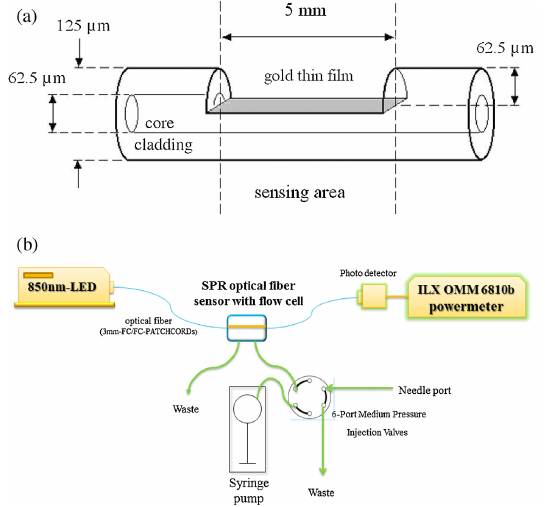
Figure 25. ( a ) Schematic diagram of the SPR optical fiber sensor featuring a side-polished structure. ( b ) The sensing system comprises an 850-nm LED light source, a side-polished SPR fiber in the flow cell, a six-port medium-pressure injection valve bulkhead, a syringe pump, a photo detector, and an OMM-6810B ILX power meter